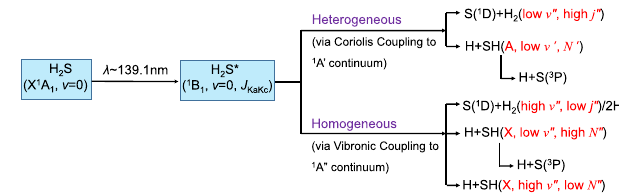
Fig. 5 Photodissociation mechanisms of H 2 S upon excitation at λ ~139.1 nm. Schematic illustration of the deduced heterogeneous (Coriolis- induced) and homogeneous (vibronic coupling) predissociation pathways following excitation to the 1 B 1 Rydberg state of H 2 S at λ ~139.1 nm. H 2 S* represents the energetic molecule formed by absorbing one 139.1 nm